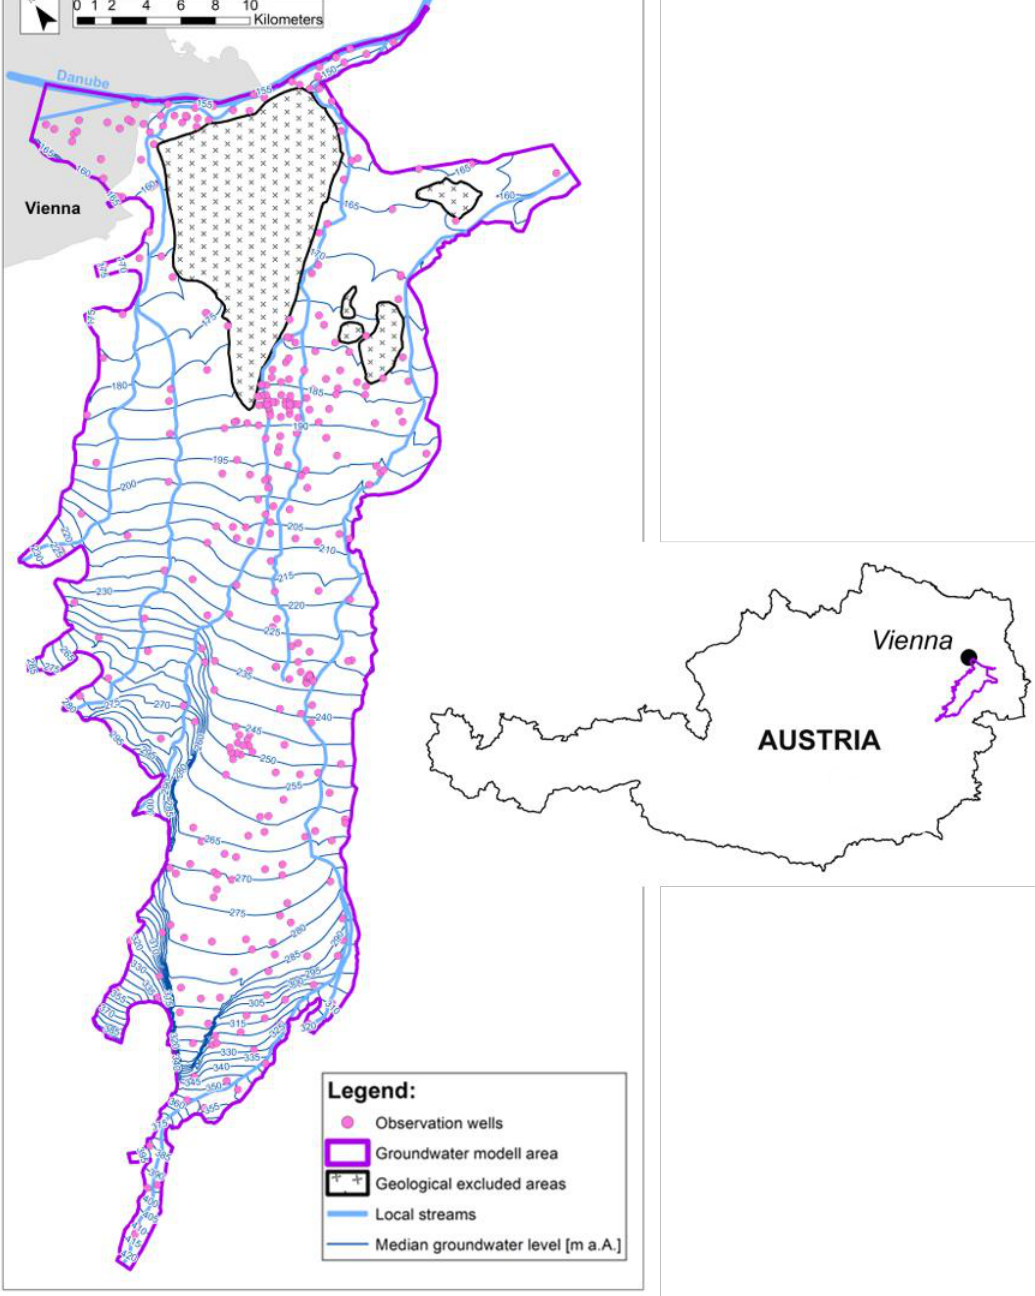
Figure 1. Location of Südliches Wiener Becken (SWB) aquifer including location of observation wells, which were used for calibration and estimation of the groundwater levels with a hundred year return period (GLsWHYRP), distribution of median groundwater level, location of surface water bodies, and excluded geological